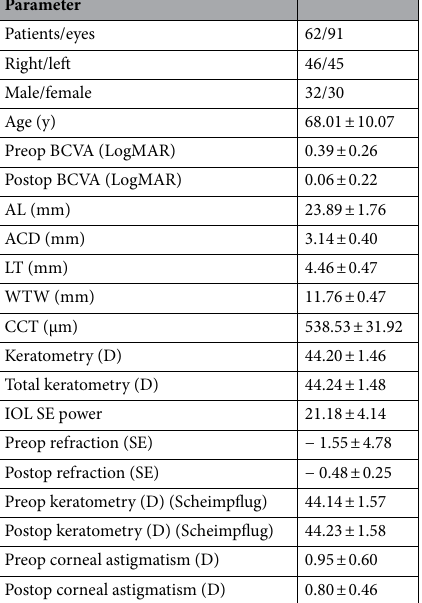
Table 1. Patient characteristics and ocular biometry data. Results are expressed as means ± standard deviation. BCVA best-corrected visual acuity, AL axial length, ACD anterior chamber depth, LT lens thickness, WTW white-to-white distance, CCT corneal center thickness, IOL intraocular lens, SE spherical